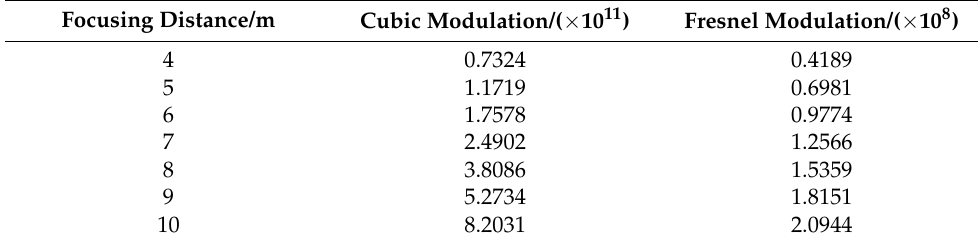
Figure 7. The maximum electrical power obtained by source metre conversion at different planes.